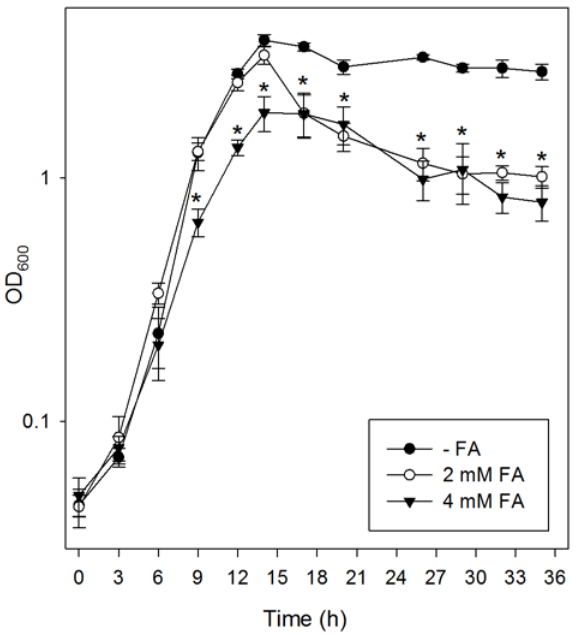
Figure 1. Effect of FA on growth of P. protegens Pf-5. Cultures of P. protegens Pf-5 were grown aerobically in E 2 glucose minimal medium supplemented or not with the indicated concentrations of FA. Growth was monitored by measurement of the OD 600 at the indicated times after inoculation. OD 600 levels are mean values for three independently grown cultures, and error bars depict standard deviations of the mean. The asterisk ( * ) denotes significant differences from the culture grown without FA (P < 0.05) using ANOVA.